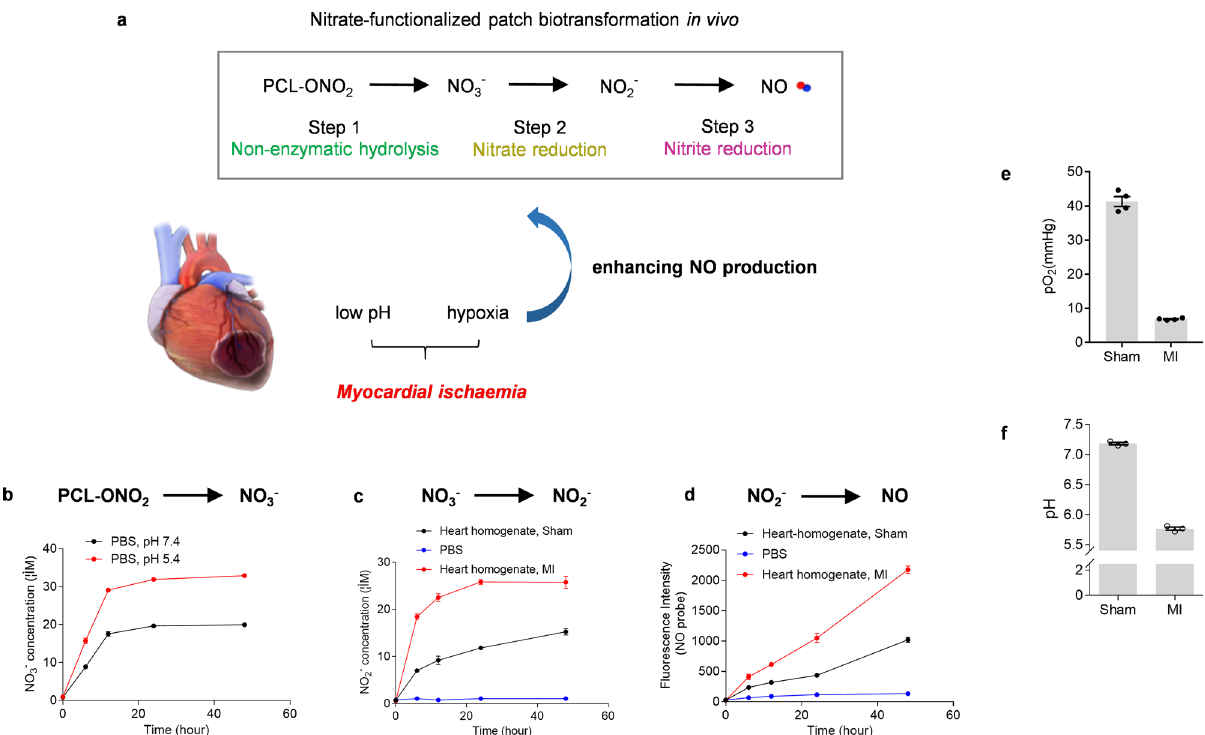
Fig. 3 Mechanistic investigation of biotransformation of nitrate-functionalized patch in the ischemic heart. a Schematic diagram illustrates the biotransformation pathway of PCL-ONO 2 into NO via a stepwise pathway. b In vitro release of NO 3 − from nitrate-functionalized patch in PBS buffer (pH = 5.4 and 7.4) through the non-enzymatic hydrolysis of PCL-ONO 2 ( n = 3). c Reduction of NO 3 − into NO 2 − in the presence of heart homogenate (10 mg/ mL) ( n = 3 independent repeats). d Reduction of NO 2 − into NO in the presence of heart homogenate (10 mg/mL) ( n = 3 independent repeats). e , f The levels of pO 2 ( n = 4 animals per group) and pH ( n = 3 animals each group) in sham operated or infarcted myocardium were measured. Data are expressed as mean ±